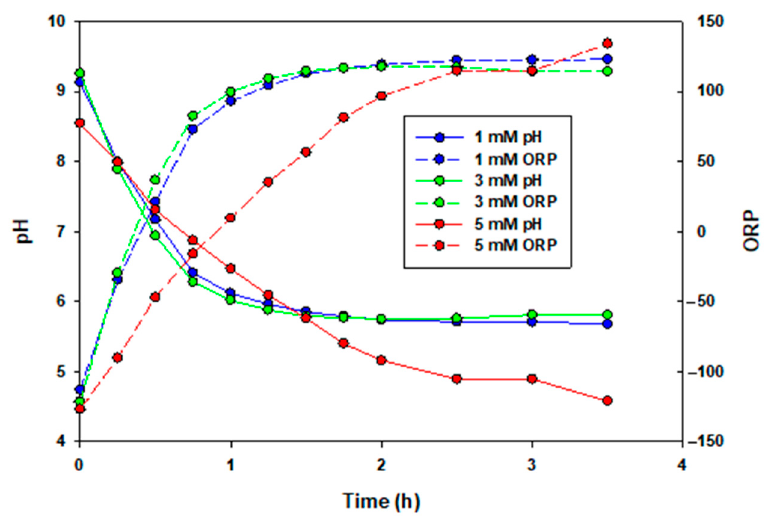
Figure 6. The time courses across the 1, 3 and 5 mM SeO 32 − concentrations for ORP and pH variation. The measured ORP values (ORP measured ) were input into the Nernst equation (Equa- tion (4)) in order to get the calculated ORP values (ORP calculated ). Thereafter, the ORP measured values were plotted against the ORP calculated ones using the SeO 32 − /Se 0 redox couple (Equa- tion (3)) for interpretation of the monitoring results.